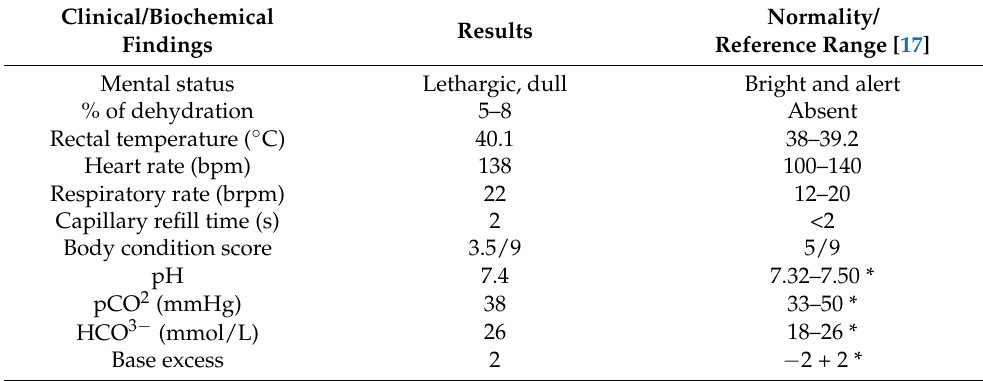
Table 1. Principal clinical fi ndings and haemogas analysis results recorded during dog ER